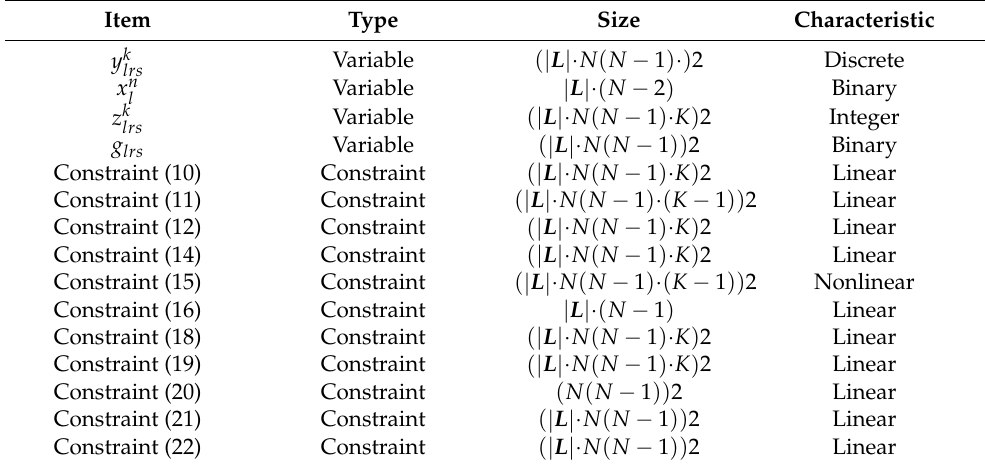
Table 4. Characteristics of the formulated